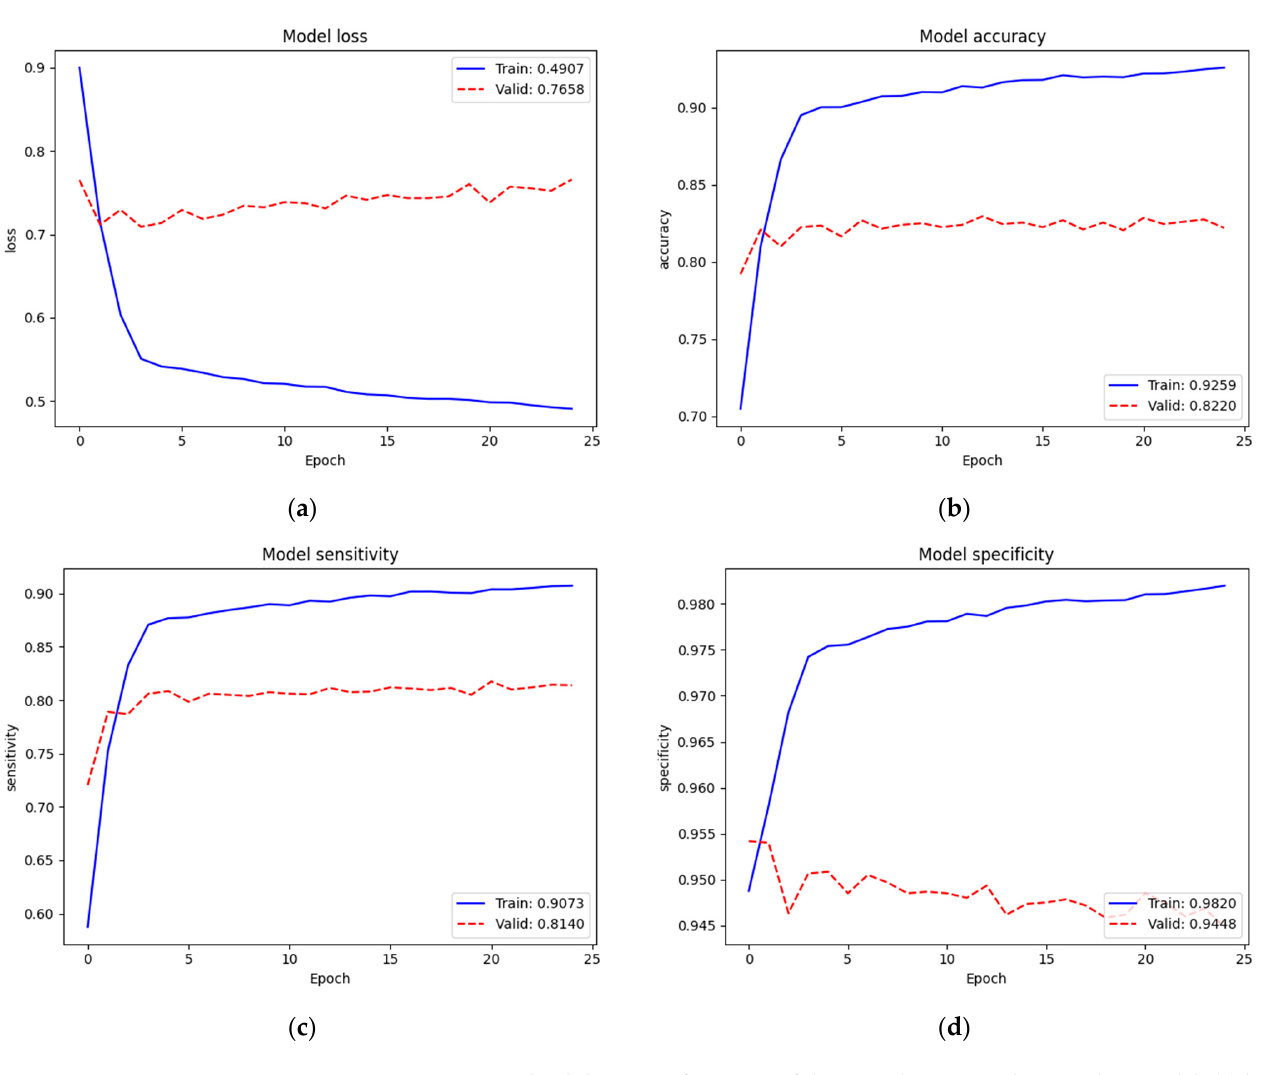
Figure 11. Training and validating performance of the SCH data set on the complete model: ( a ) loss; ( b ) accuracy; ( c ) sensitivity; ( d ) specificity. Table 10. Summary of the validation performance of the SCH data set. Train Loss Accuracy Sensitivity Specificity Train from scratch (1st train) 1.1790